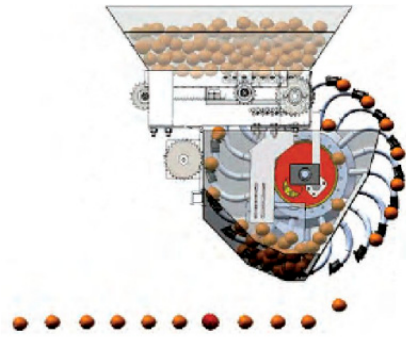
Figure 24. The intelligent seed supply system of the air-suction potato planter. Reprinted with per- mission from ref. [18] Copyright 2022 Northeast Agricultural University.